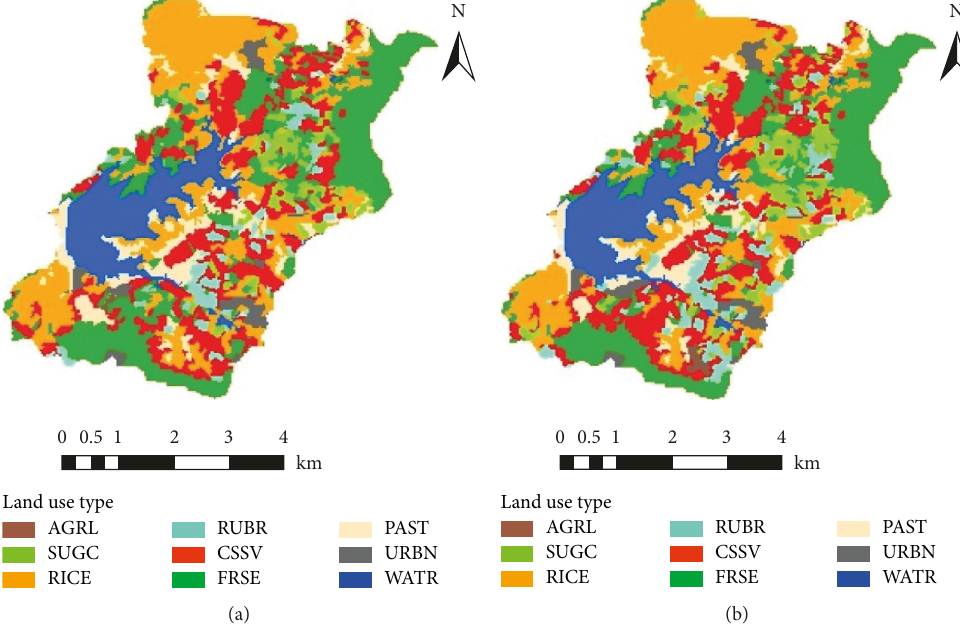
Figure 2: Huay Sabag baseline land use maps: (a) year 2010 and (b) year